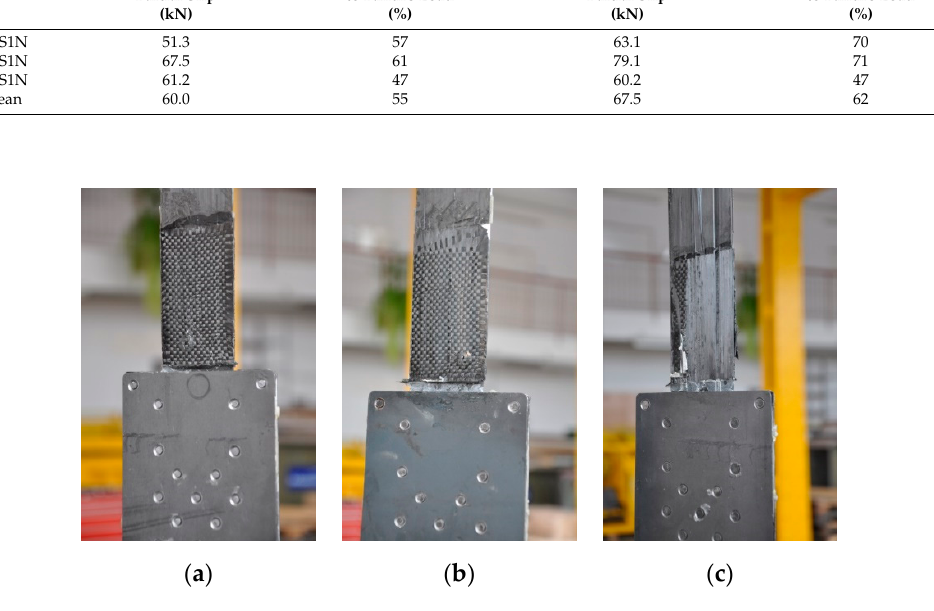
Figure 13. Failure mode of the subsequent specimens in the S1N series: ( a ) P1/S1N, ( b ) P2/S1N, ( c ) P3/S1N.